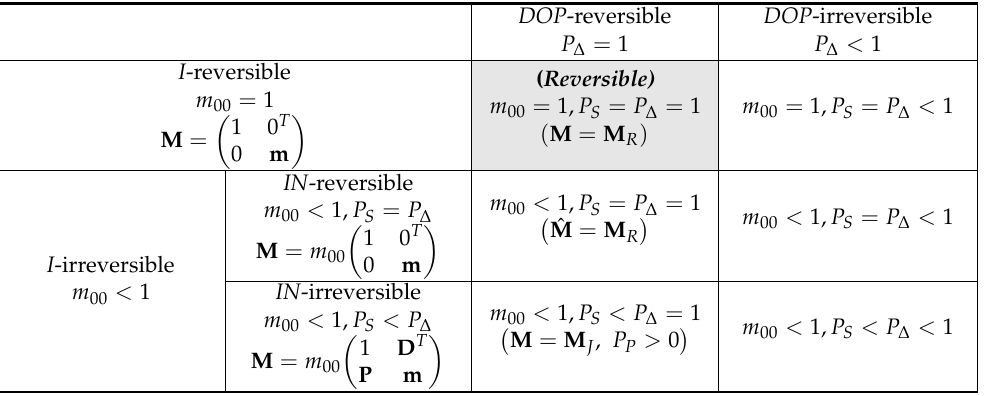
Table 1. Classification of Mueller matrices in terms of their reversibility-irreversibility properties.